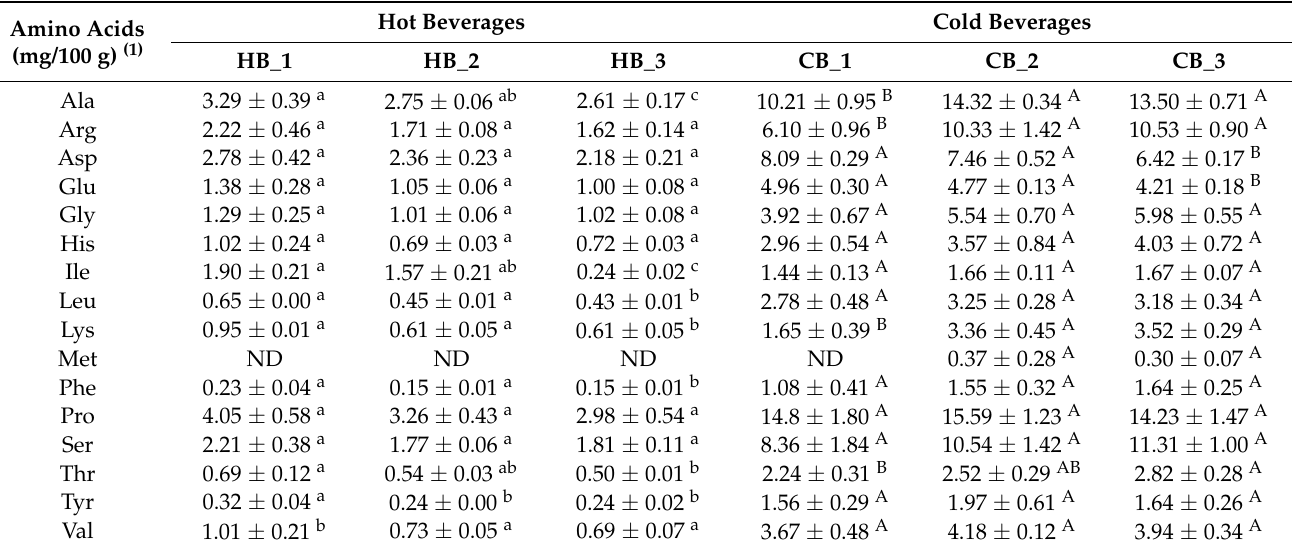
Table 1. Amino acid profile of hot- and cold-brewed